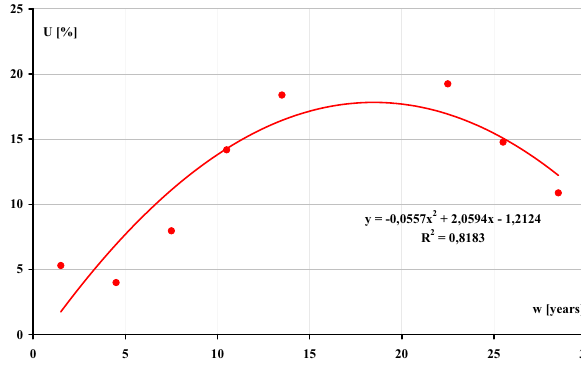
Figure 6: Dependence of vehicle share with faults among vehicles in a given age range.